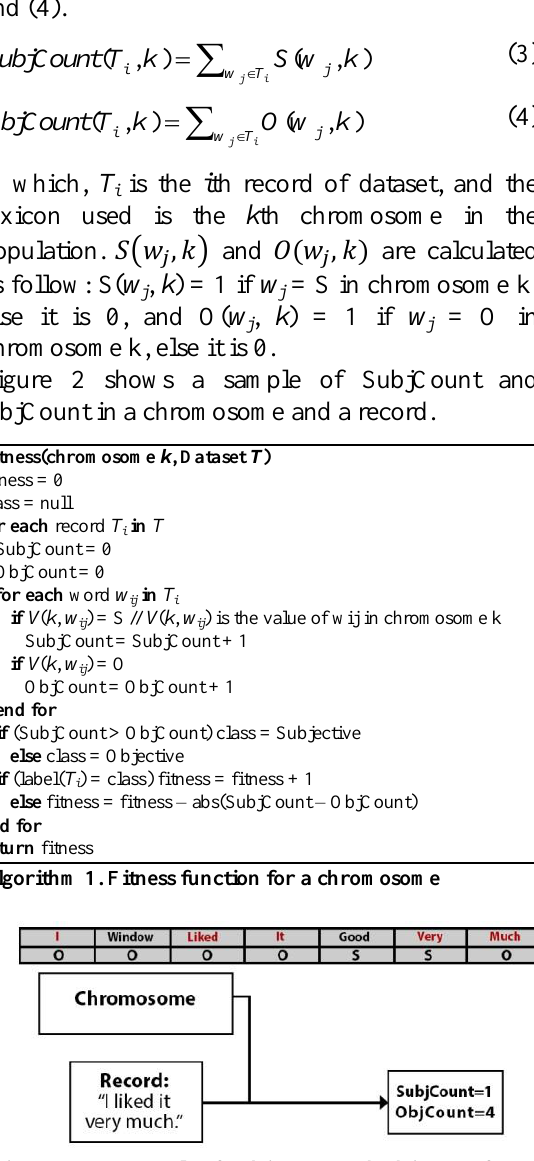
Figure 2. An example of SubjCount and ObjCount for a record